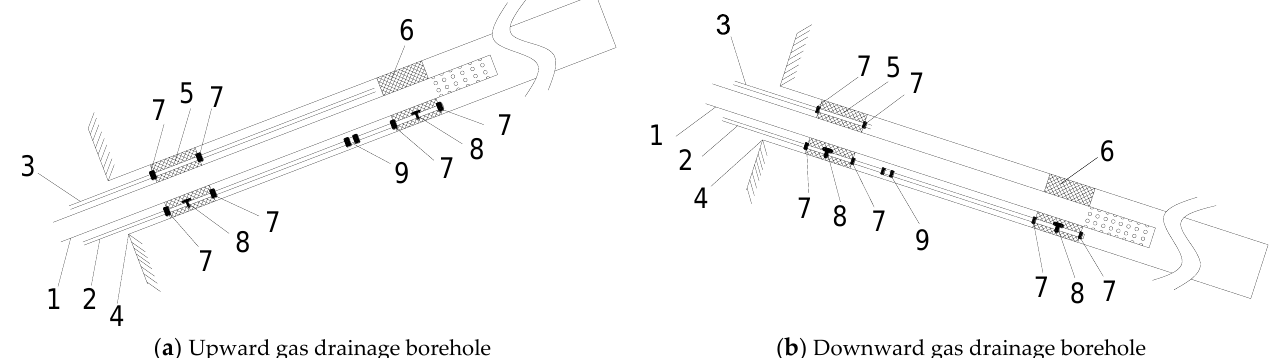
( a ) Upward gas drainage borehole ( b ) Downward gas drainage borehole Figure 12. Schematic diagram of structures of hole packers for upward boreholes. 1 Extraction pipe; 2 grouting pipe; 3 grouting pipe; 4 mine drilling; 5 external blocking bag; 6 inner blocking bag; 7 metal clamp; 8 one-way valve; 9 burst valve.